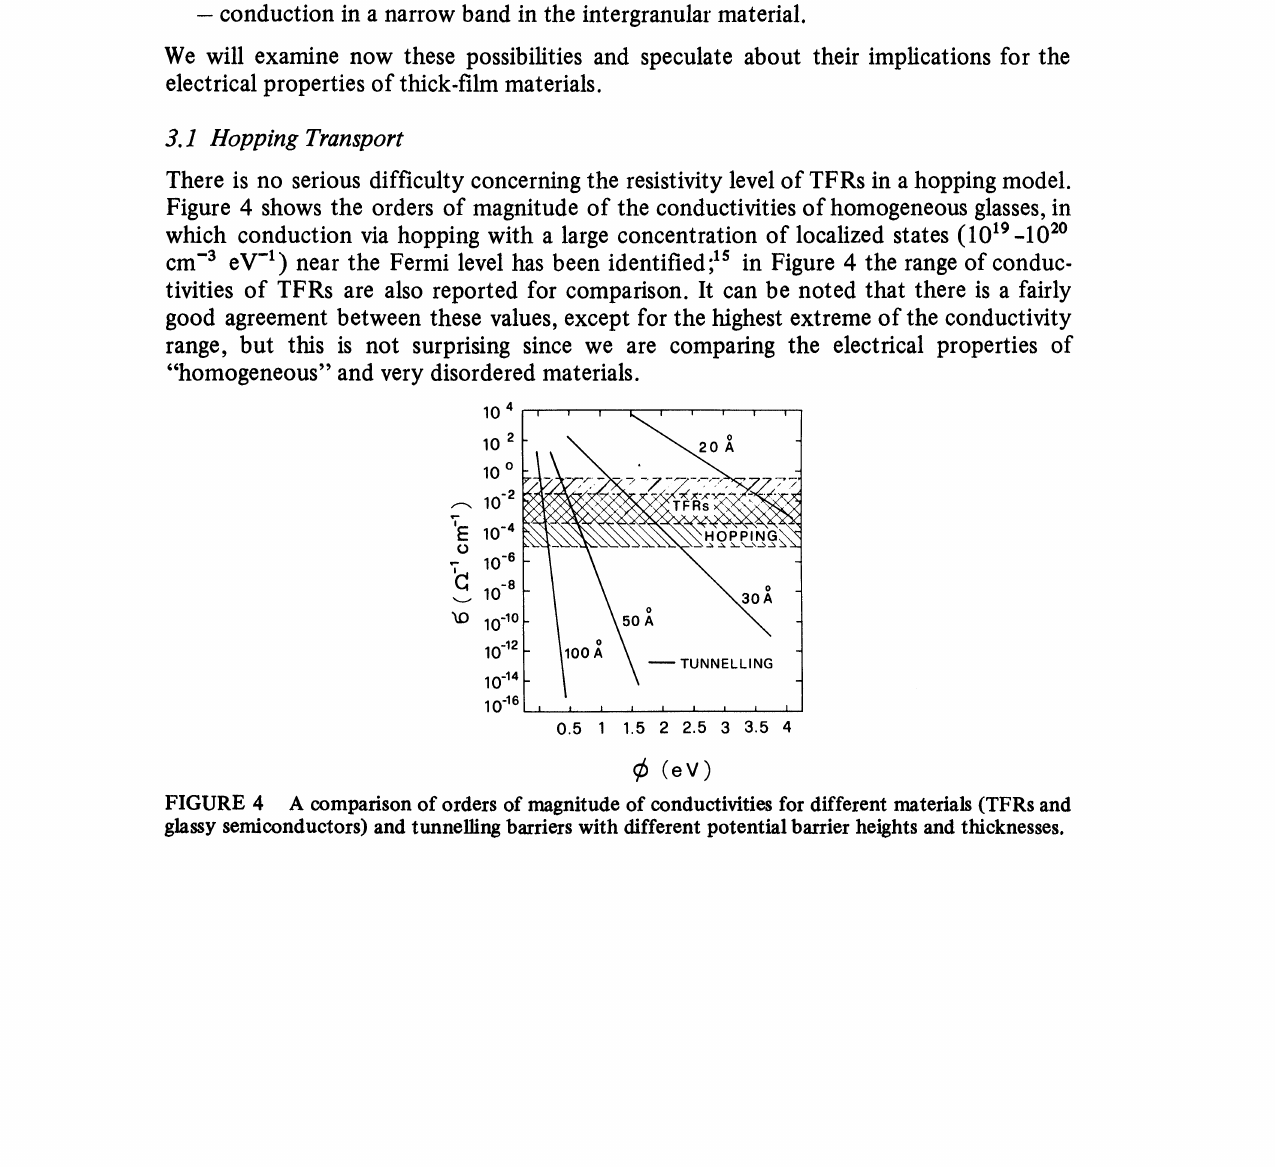
A comparison of orders of magnitude of conduetivities for different materials (TFRs and glassy semiconductors) and tunnelling barriers with different potential barrier heights and